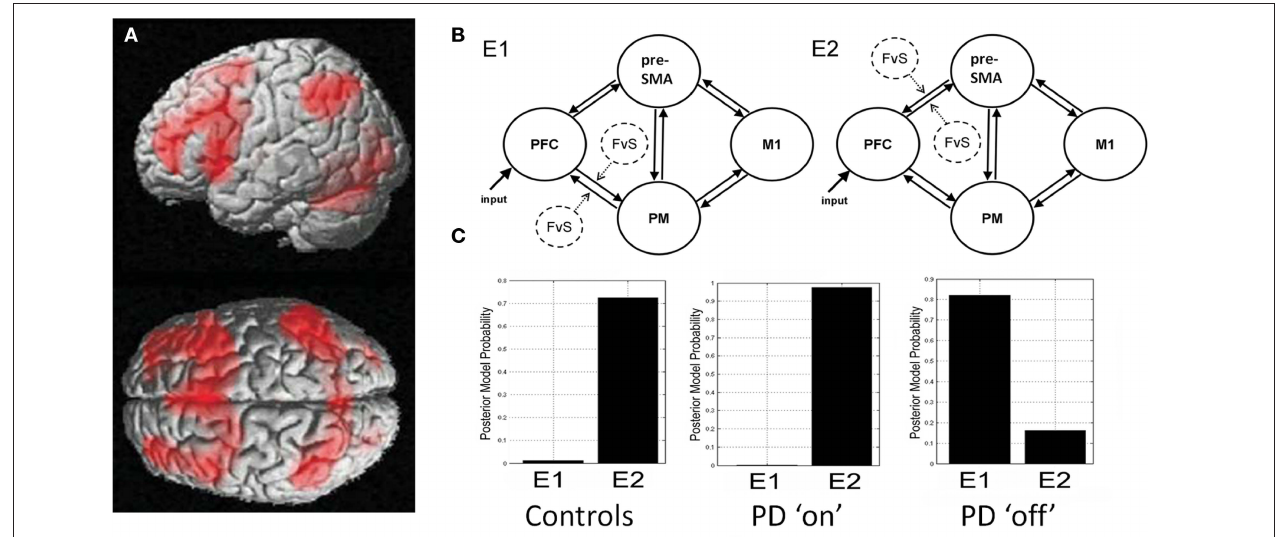
and patients on their dopaminergic medication, model E2 was more likely (by the posterior model probability, based on the free energy estimate of the log of model- evidence, adjusted for model complexity) in which the selection of action (FvS) was associated with greater connectivity of PFC to pre-SMA. When withdrawn from medication, to a relative “off” state, the connectivity pattern in PD patients changed to a state in which the selection of action was associated with greater connectivity between PFC and the PMC, model E1. This confirmed the hypothesis of a functional disconnection of the pre-SMA, and an enhanced role of the lateral PMC in action selection in PD. From Rowe et al.